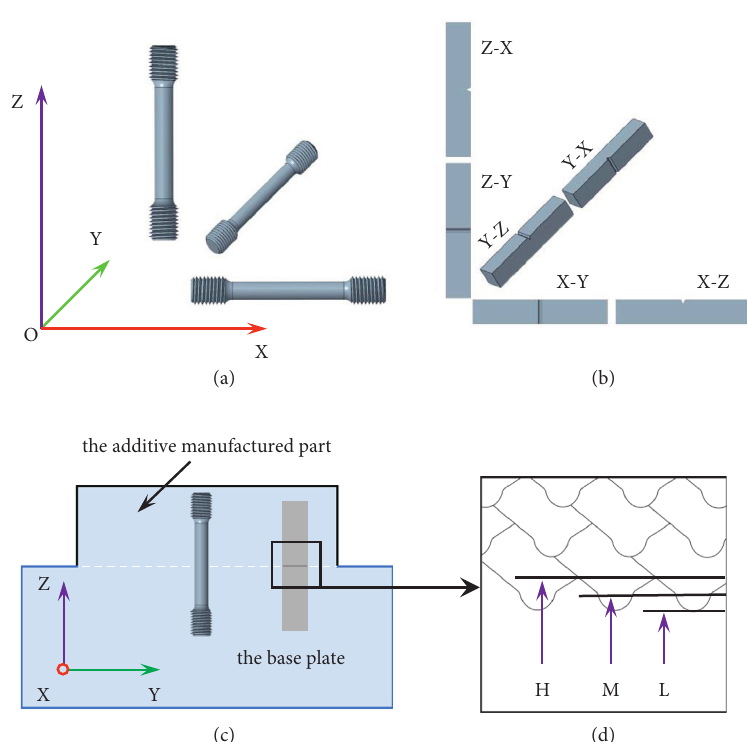
Figure 2: Schematic illustrations of sampling locations. (a) Tensile tests, (b) impact test sampling of the AM part, (c) tensile and impact test sampling locations, and (d) V notch locations of impact test samples of the HAM